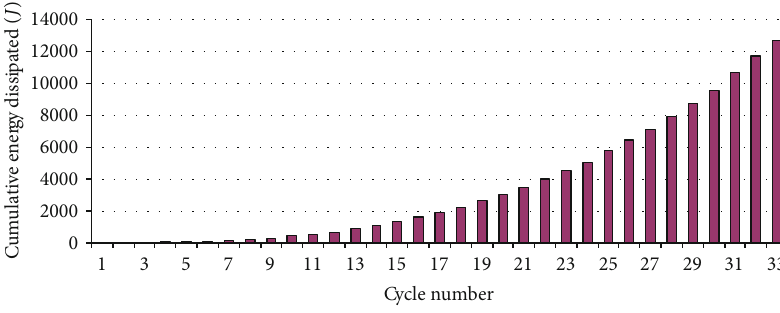
Figure 9: Cumulative energy dissipation of column